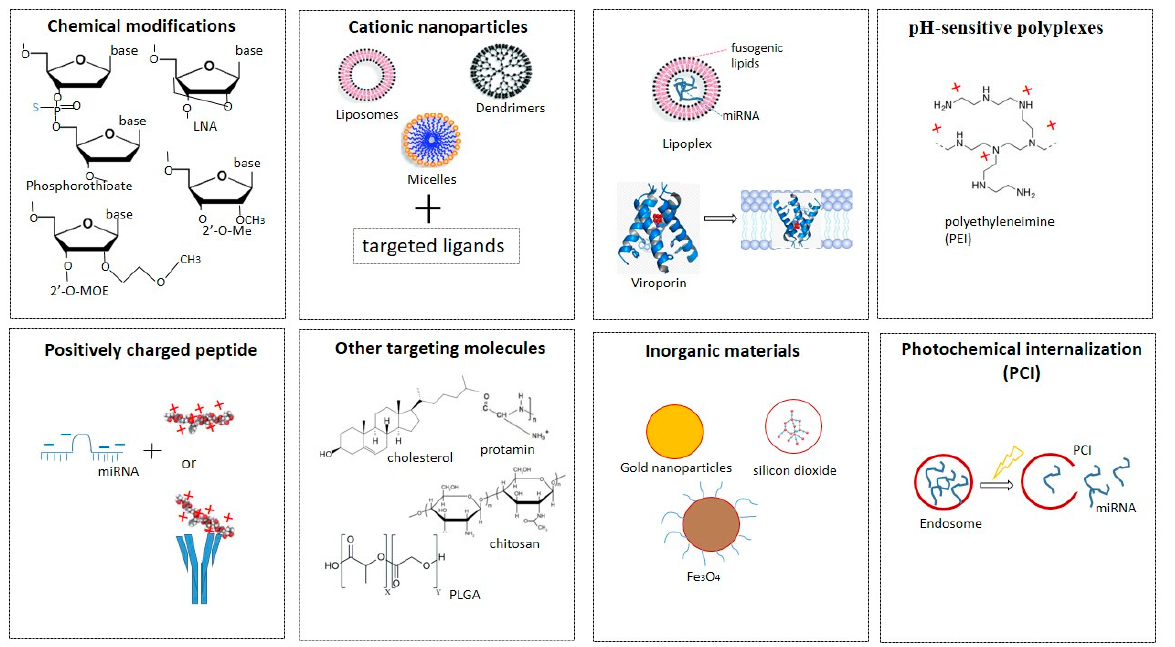
Figure 4. The various approaches to maintaining the stability of miRNAs in vivo and ensuring targeted delivery to cells.